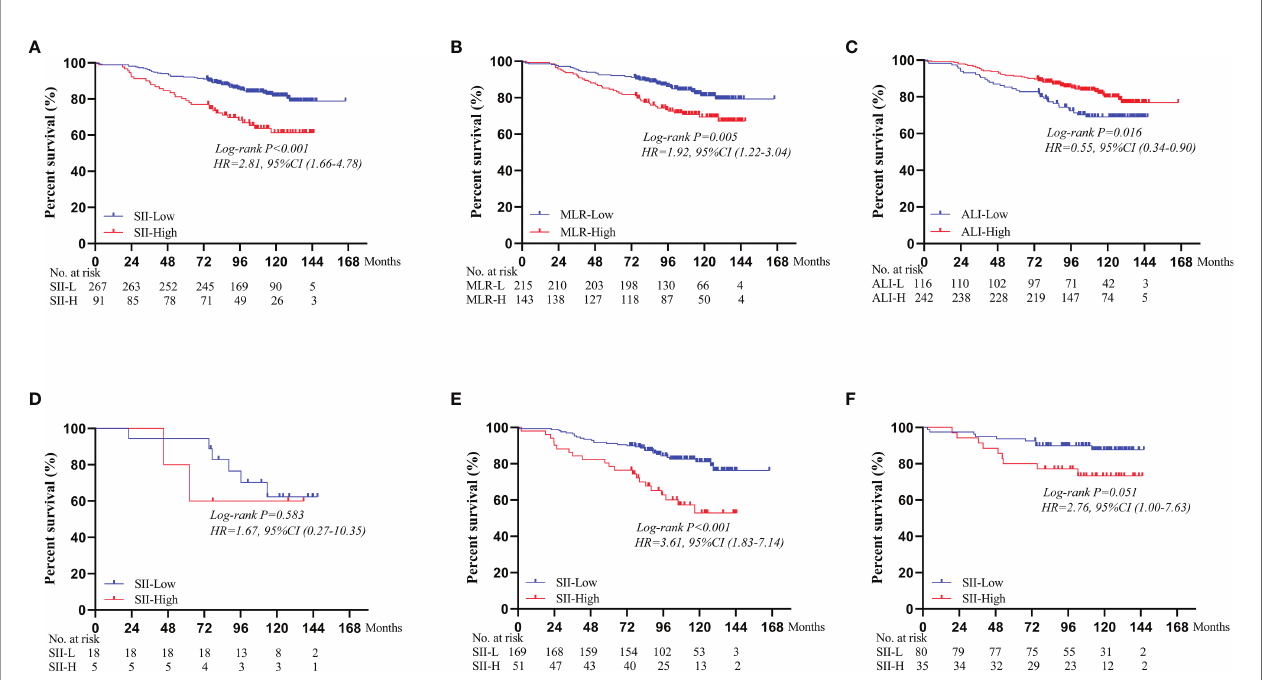
FIGURE 2 | Subgroup survival analyses for different immunoin fl ammatory indices: (A) SII. (B) MLR. (C) ALI. Survival curves of OS comparing SII-L group and SII-H group according to the BMI score: (D) In the BMI < 18.5 group. (E) In the 18.5 ≤ BMI < 25.0 group. (F) In the BMI ≥ 25.0 group. SII, systemic immune-in fl ammation index; MLR, monocyte to lymphocyte ratio; ALI, advanced lung cancer in fl ammation index; BMI, body mass